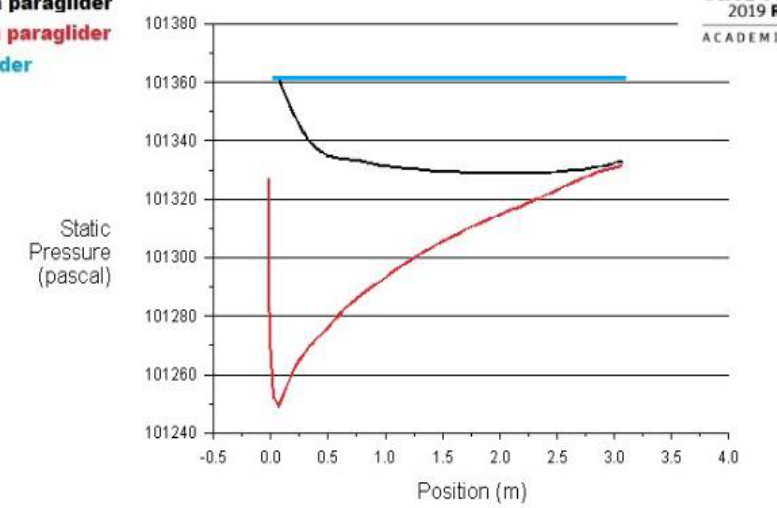
Figure 9. Pressure change vs. the distance from the leading edge in the symmetry plane (paraglider made of air-permeable material, referring to sample no. 9).